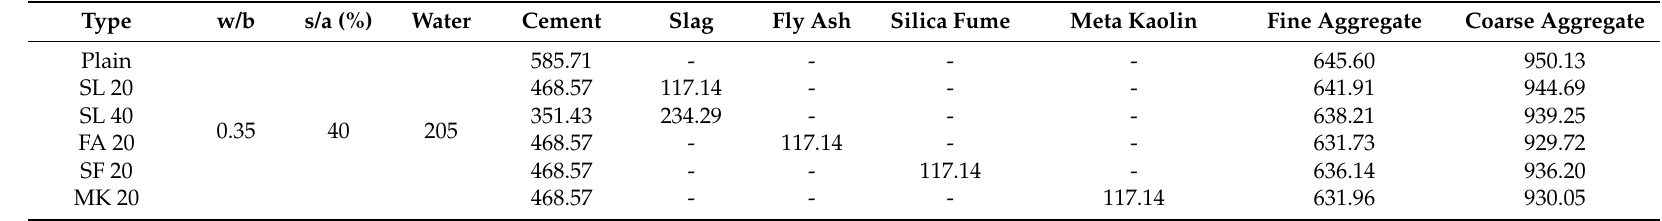
Table 2. Mix proportions of concrete (kg/m 3